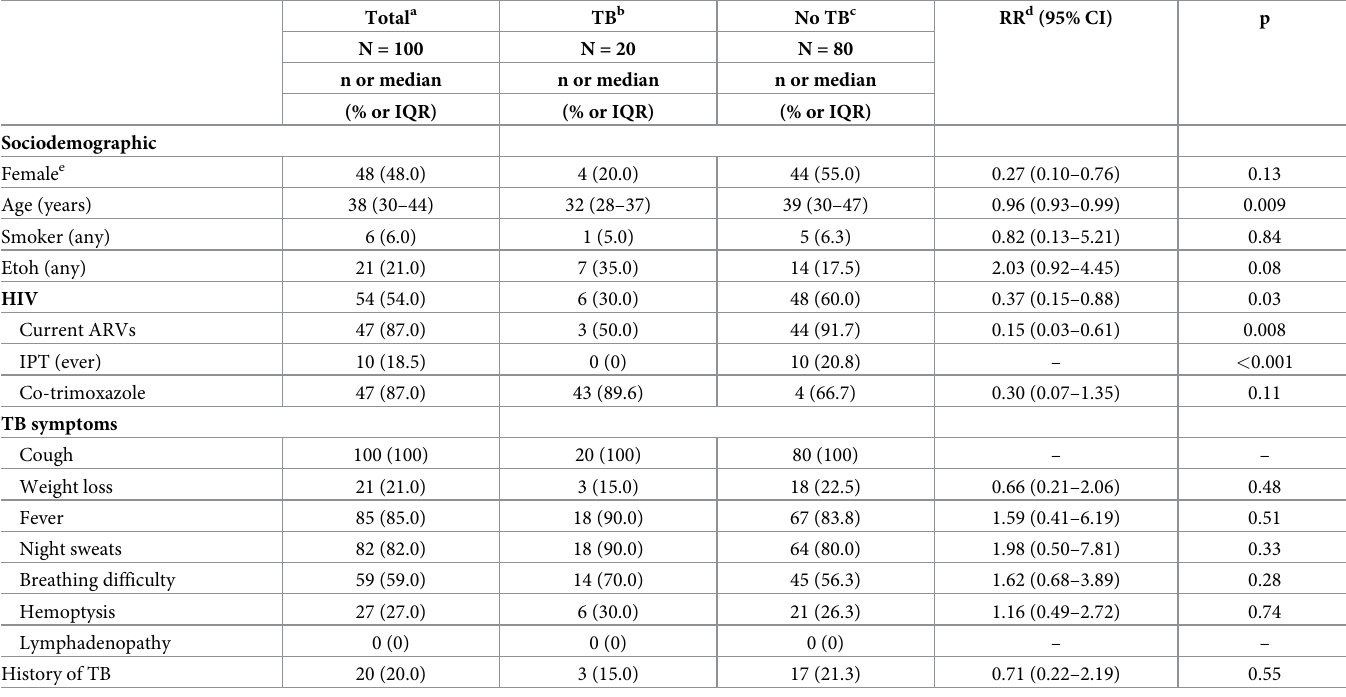
Abbreviations: TB: tuberculosis; IPT: isoniazid preventive therapy. a Participants suspected of TB with cough � 2 weeks as well as at least one additional symptom (fever, weight loss, night sweats, or hemoptysis). b Either sputum culture or Xpert positive for M . tuberculosis .